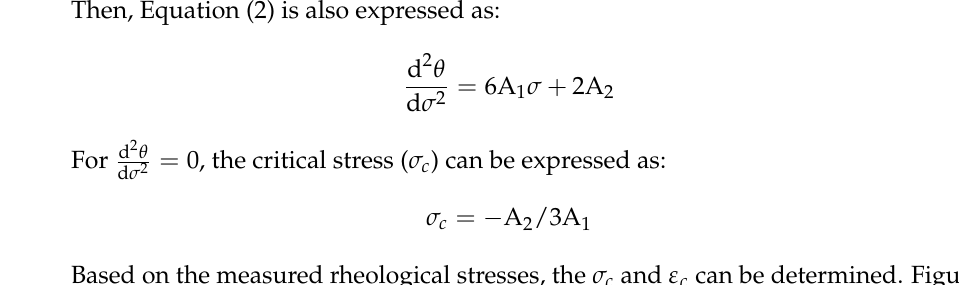
Based on the measured rheological stresses, the σ c and ε c can be determined. Figure 8 displays the values of under various conditions. Obviously, the reduced temperature or the raised strain rate increase ε c .